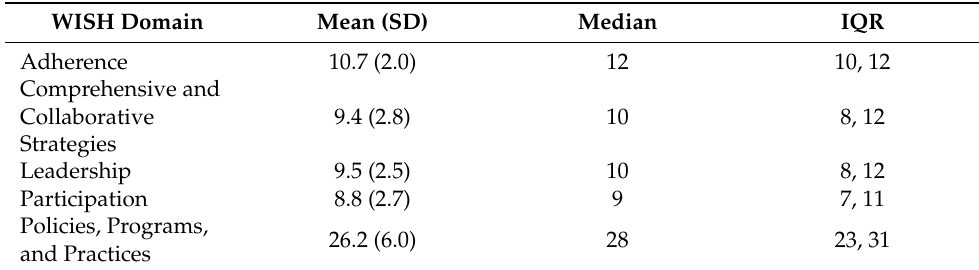
Table 2. Descriptive Statistics of WISH Domains.